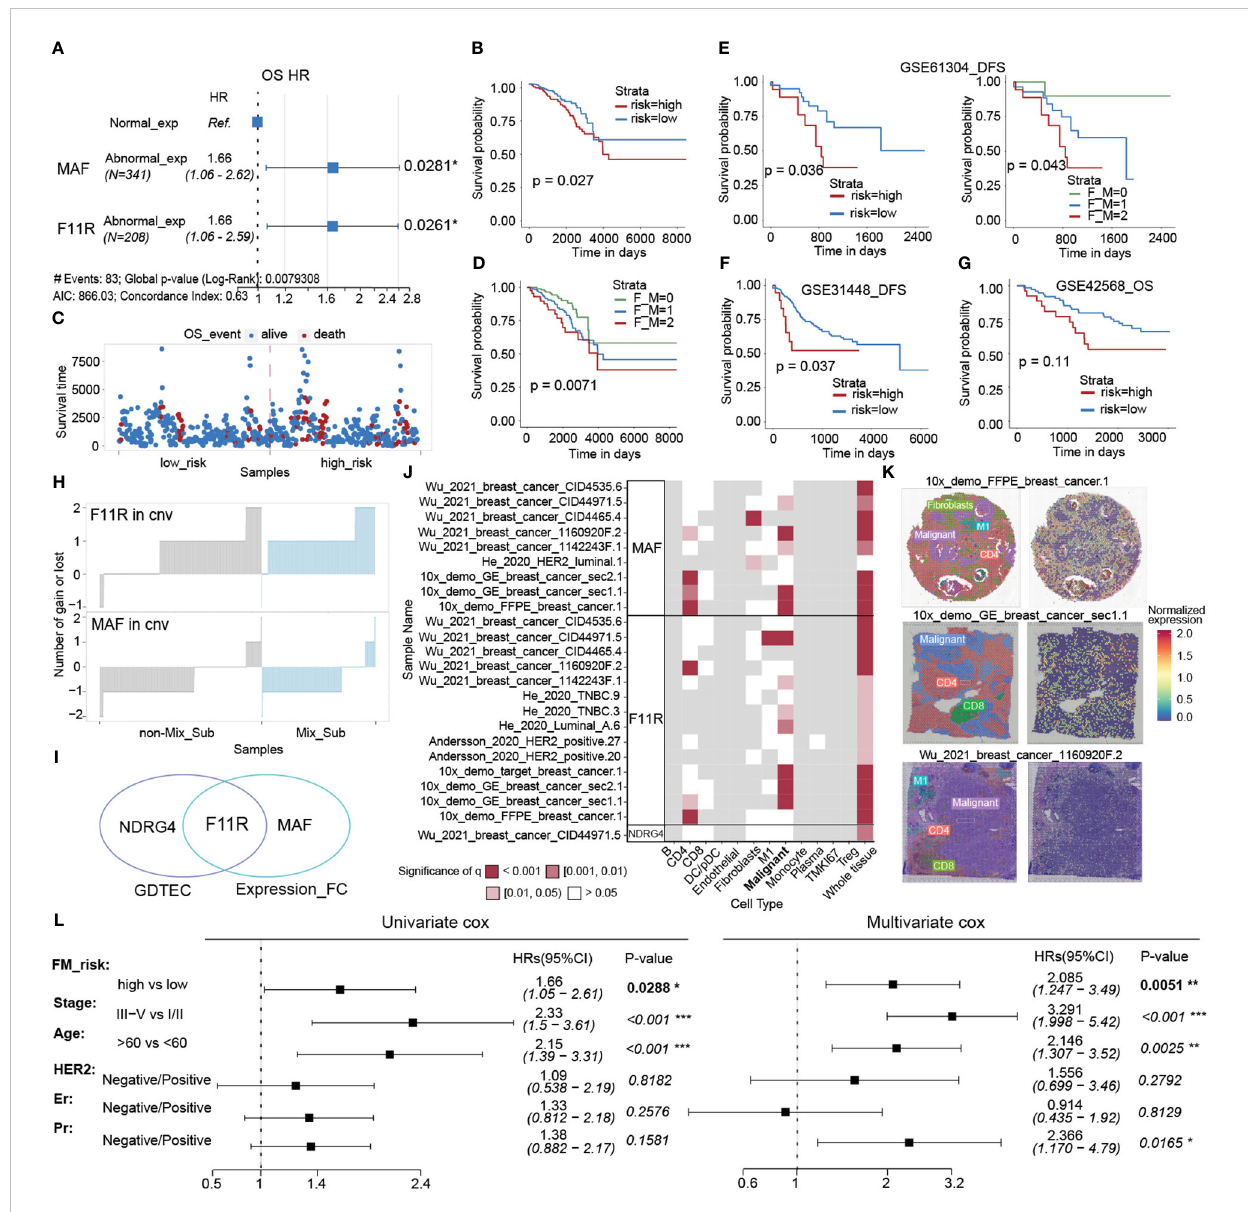
FIGURE 10 (A) Multivariate cox regression model constructed with the LFC of F11R and MAF as features. (B) The Kaplan-Meier survival curve for classifying the high and low risks of the TCGA-BRCA samples was constructed by F11R and MAF. (C) Survival status of patients in the high risk and low risk groups. (D) The Kaplan-Meier survival curvet of the three groups of breast cancer patients is grouped according to the LFC of the two risk genes, F11R and MAF. F_M = 0, indicating that both genes were normally expressed. F_M = 1, indicating that one gene was abnormally expressed. F_M = 2, indicating that both genes were abnormally expressed. (E – G) Kaplan-Meier survival curve of patients in the high-risk and low-risk groups using the GSE61304, GSE31448, and GSE42568 datasets to validate the constructed risk-prognosis models. (H) The copy number variation of F11R and MAF in each sample. (I) Risk prognostic factors identi fi ed at two levels. (J) Spatial variability of MAF, F11R and NDRG4 in typical samples, and the landscape of more samples was displayed in S4. (K) Normalized spatial gene expression of MAF in three representative samples and annotated cell types. (L) Univariate and multivariate analysis of the FM_risk scores with other standard clinical features in the breast